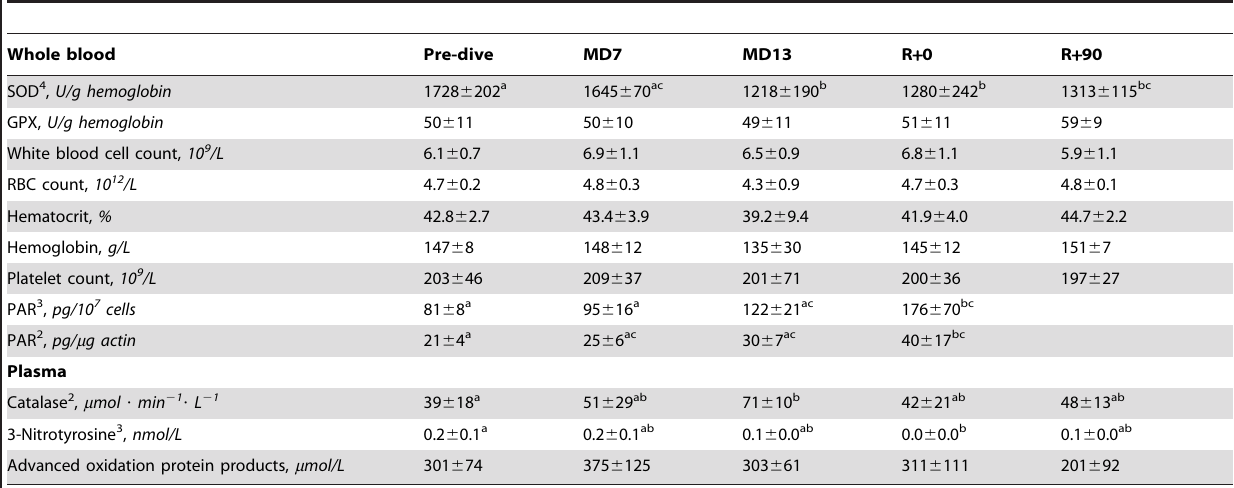
Table 1. Whole blood and plasma variables related to oxidative damage, iron status, DNA damage, and vitamin metabolism before, during, and after a 13-d saturation dive in humans 1